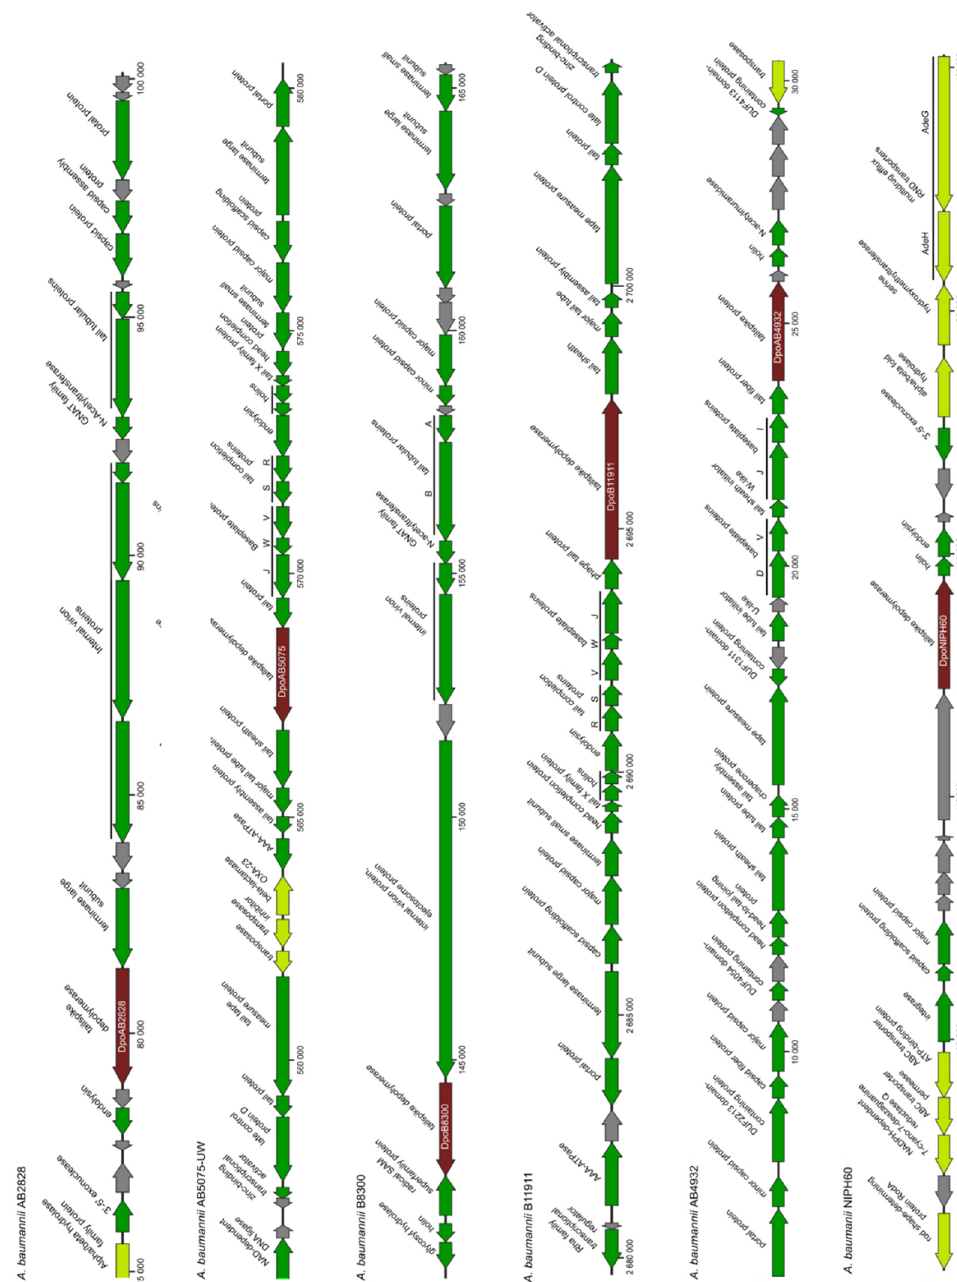
Figure 1. Genetic maps of A. baumannii genome fragments (approximately 25,000 base pairs) con- taining determined prophage-derived genes. ORFs are indicated as arrows, the direction of an arrow shows the direction of transcription. The names of A. baumannii strains, where the genes encoding structural depolymerases have been found, are shown above the genetic maps. The ORFs were validated and curated using a search in the non-redundant database of the NCBI and HHpred profile–profile search. The ORFs are coloured according to the following predictions: green for prophage-derived genes encoding phage assembly and structural proteins, products involved in phage nucleotide metabolism, packaging of DNA into the capsid, bacterial cell lysis, and integration of phage DNA into the bacterial genomes; dark red for the genes encoding predicted structural or tailspike depolymerases, conditionally designated as DpoAB2828, DpoAB5075, DpoB8300, DpoB11911, DpoAB4932, and DpoNIPH60; gray for genes of hypothetical proteins; light green for genes responsible for the functioning of the bacterial cells. Maps were created using SnapGene software (from Insightful Science; available at snapgene.com).